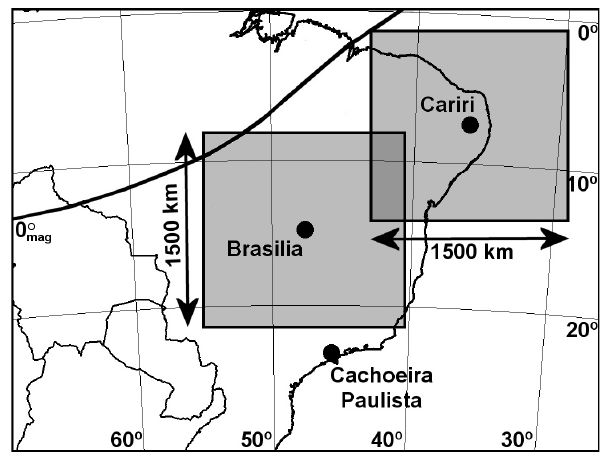
Fig. 1. Map of Brazil showing the all-sky imager locations during the SpreadFEx campaign and their proximity to the magnetic equa- tor. The boxes represent the 1500 × 1500km area corresponding to the unwarped OI (630nm) images for the Brasilia and Cariri sites, assuming an emission altitude of